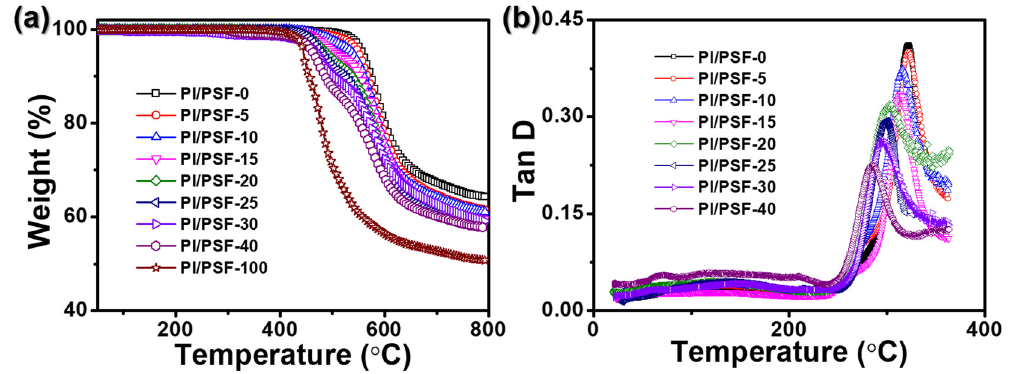
Figure 5: TGA ( a ) and DMA ( b ) curves of PI/PSF - X composite